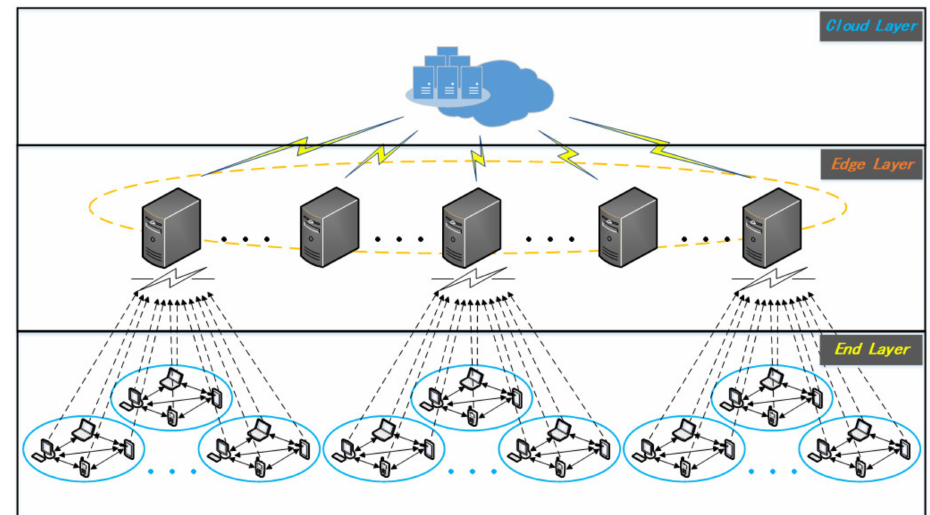
Figure 2. Cloud-Edge-End Collaboration (CEEC) computing power